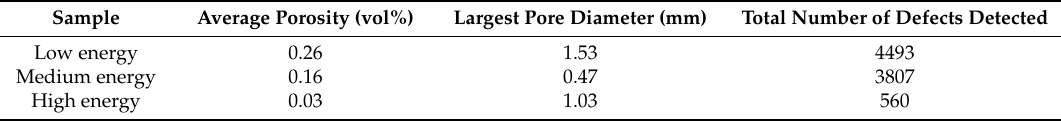
Table 4. Porosity measurements using micro-computed tomography (micro-CT) (Volume studied: ~250 mm 3 ).